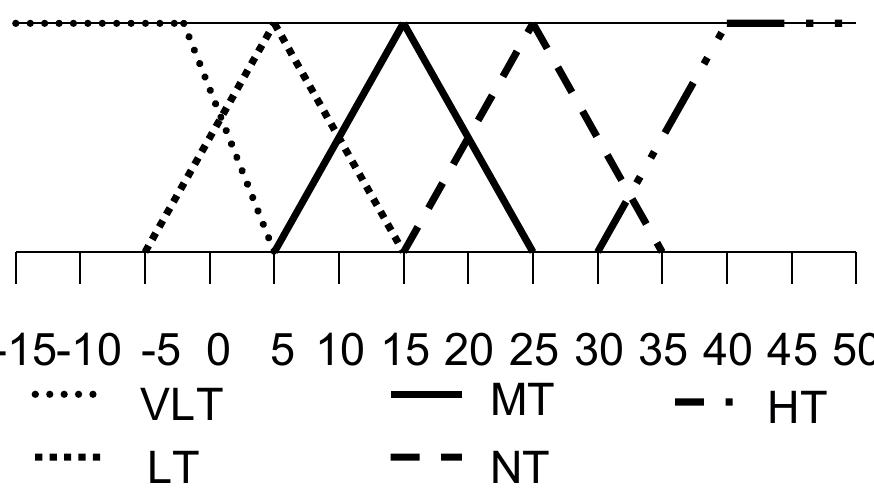
Figure 4. Watering Temp Control Fuzzy sets over crisp input values.